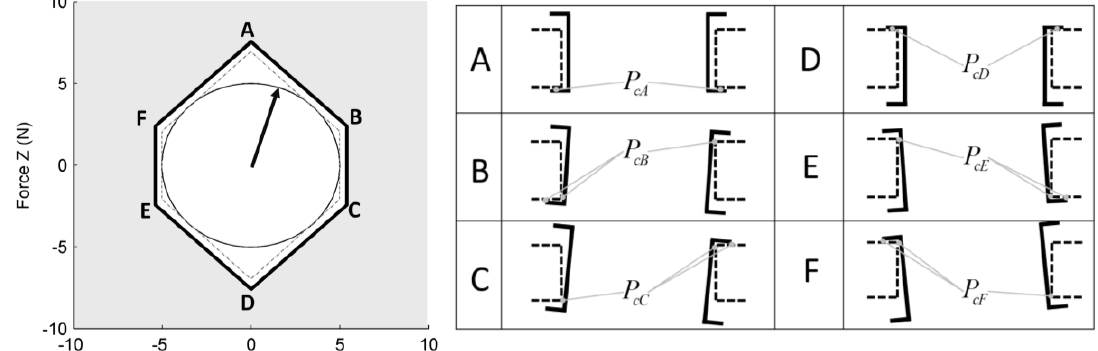
Figure 10. Representation of the overload protection limits to the applied force. Overload protection is active for the forces that fall in the grey area (left picture) outside the polygon ABCDEF. It’s important to underline that nominal forces fall inside the circle that is in turn fully included in the area of the polygon. The figure on the right shows the actual displacements of the moving constraint-surface produced by forces that corresponds to the points